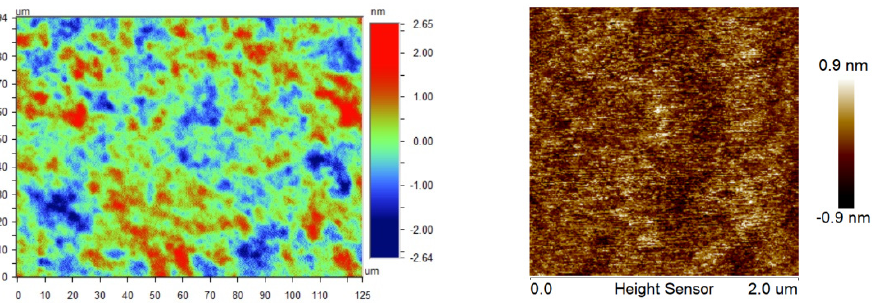
Figure 11. Si<111> surface morphology after CMP by performing profilometry within 125 μ m × 94 μ m ( left ) and AFM within 2 μ m × 2 μ m ( right ). Table 2. The RMS roughness over a 5 point test of profilometry and 2 point test of AFM for 5 repetitions. RMS by Profilometry (nm) RMS by AFM (nm)